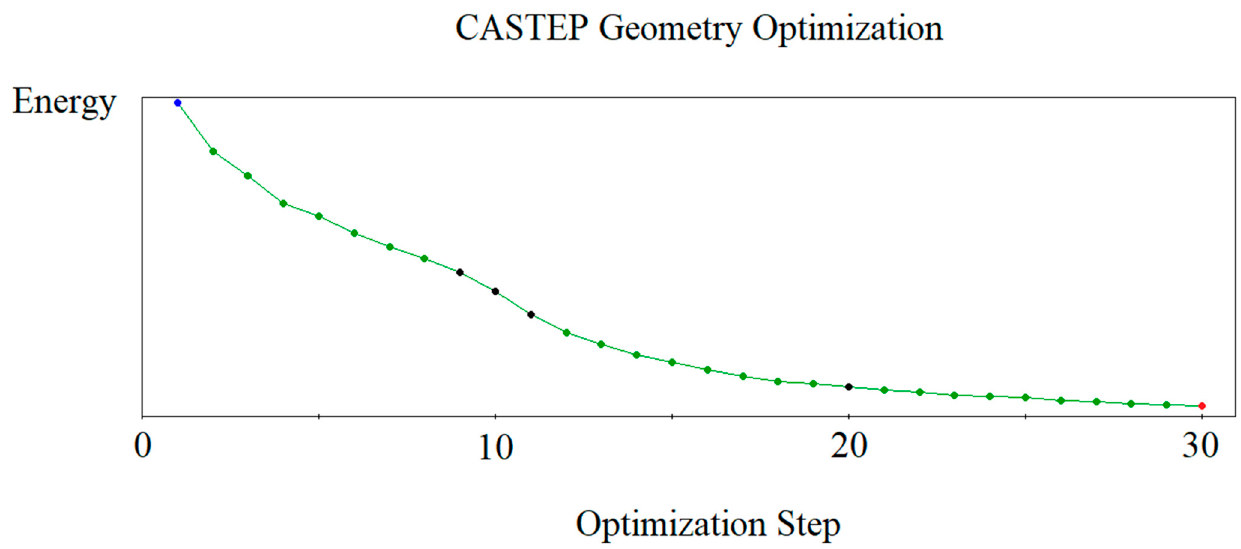
Figure 4. DFT optimization energy profile. Relevant optimization steps are colored: blue for the initial optimization step, black for 9, 10, 11 and 20 optimization steps, respectively and red for the final optimization step.